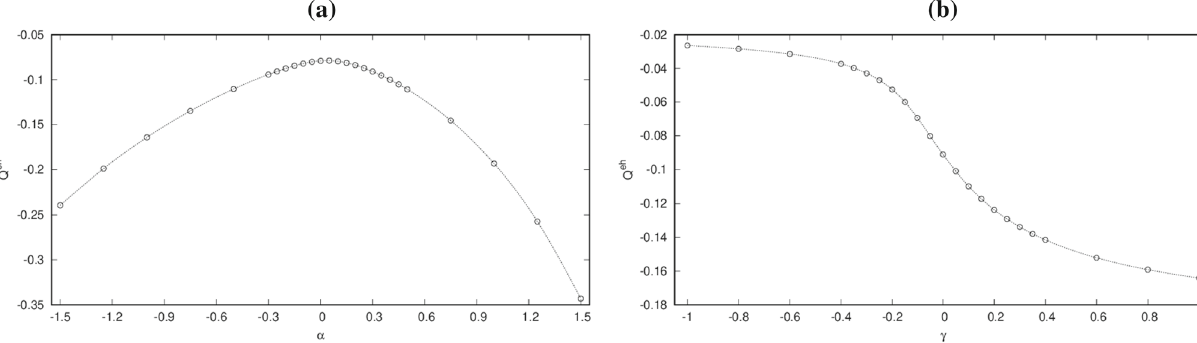
Fig. 7 The black hole charge related to the U ( 1 ) gauge field, Q eh , as function of a α and b γ , for non-varying parameters as in Fig.